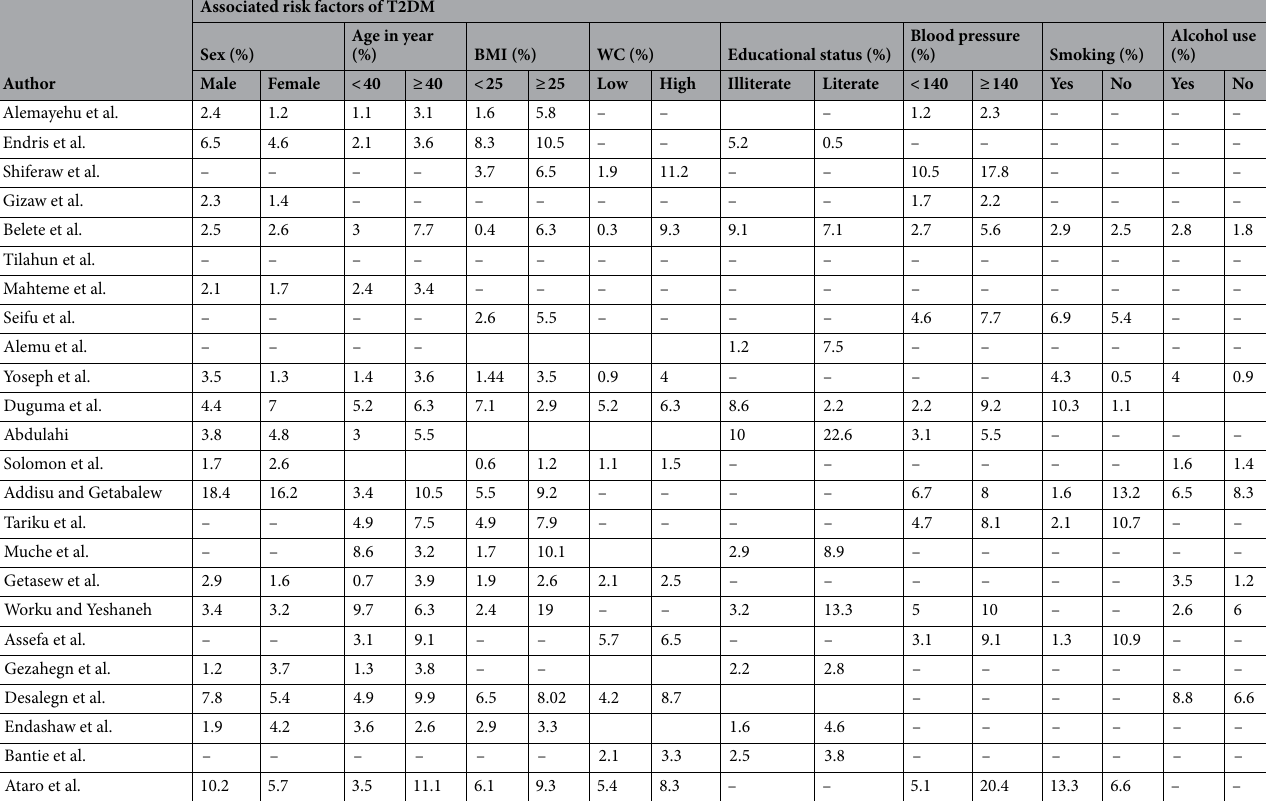
Table 2. Summary statistics for the prevalence of T2DM by risk factors for each